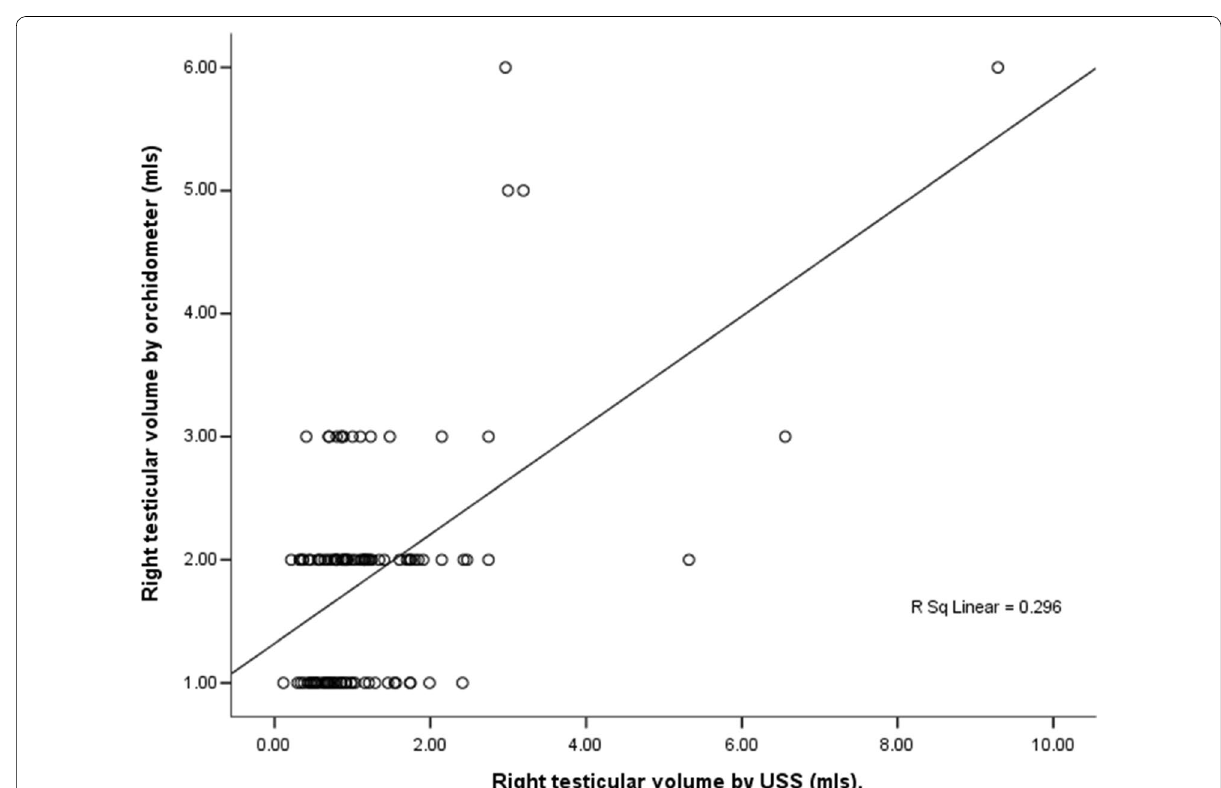
Fig. 1 Scatter plot of right testicular volume measurements by orchidometry and